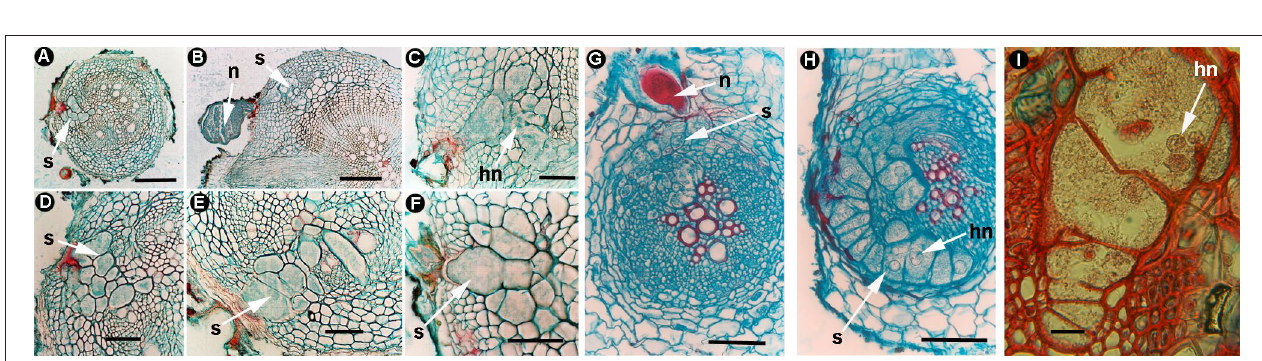
FIGURE 4 | Morphogenesis in cyst nematodes forming syncytia. Heterodera spp. (A–I) : Heterodera cruciferae (A–F) Transverse sections of cabbage roots infected by H. cruciferae showing the semi-endoparasitic adult female (n) inducing the cortical and stellar syncytium (s) with fused syncytial cells with dense cytoplasm and hypertrophic nuclei (hn) ((Sasanelli et al., 2013); with permission of The American Phytopathological Society). Heterodera daverti (G,H) Cross-sections of white clover roots showing the semi-endoparasitic adult female (n) inducing the cortical and stellar syncytium (s) with fused syncytial cells presenting dense cytoplasm and hypertrophic nuclei (hn) (Vovlas et al., 2015a; with permission of Springer). Heterodera filipjevi (I) Detail of syncytial cells in wheat roots showing hypertrophic nuclei (hn) (Source: N. Vovlas). Scale bars: A = 1,000 µ m; B,G,H = 500 µ m; C–F,I = 100 µ m.